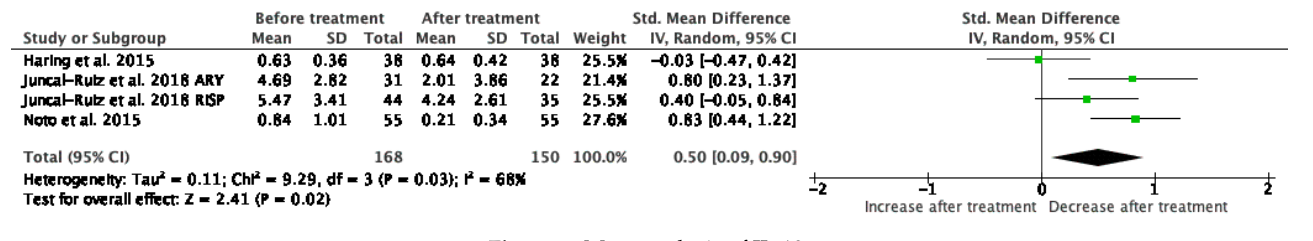
Figure 2. Meta-analysis of IL-10.